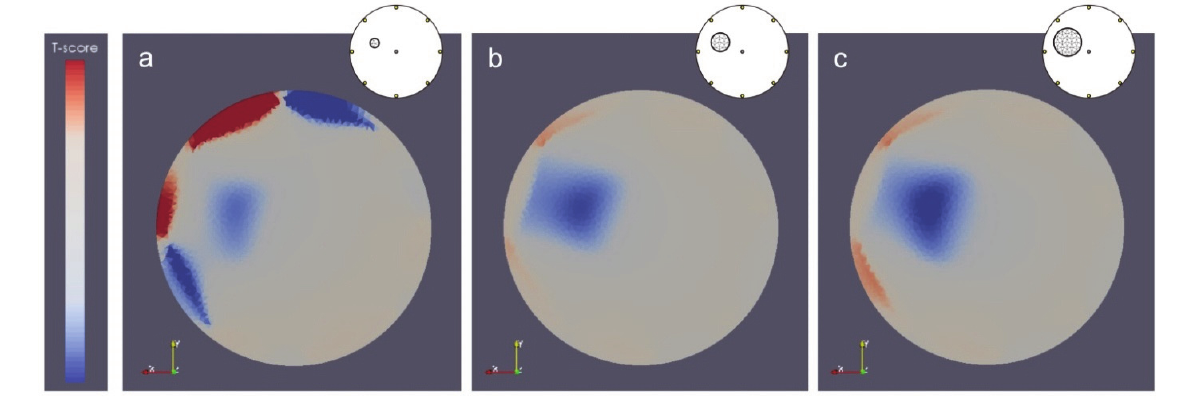
Fig. 5: Image reconstruction (top view) in t-EIT for a cylindrical plastic object placed in the measurement chamber filled with electrolyte using the polar-offset configuration (Fig. 2b) and the customised algorithm. The real position is shown in the schematics at the top (centre-to-centre distance between the object and the chamber: 2.5 mm, angle: 112.5°). Image reconstruction of (a) 1 mm, (b) 2 mm; and (c) 3 mm phantom. The colour scale is in arbitrary units (from -1 in blue, to +1 in red) representing the T-score.